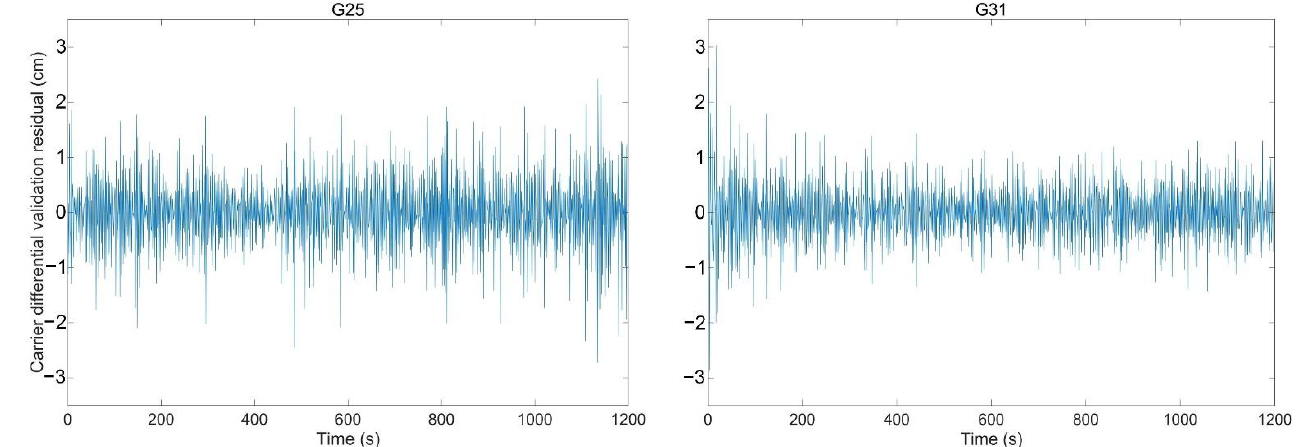
Figure 4. G05, G15, G25, G31 carrier differential validation.